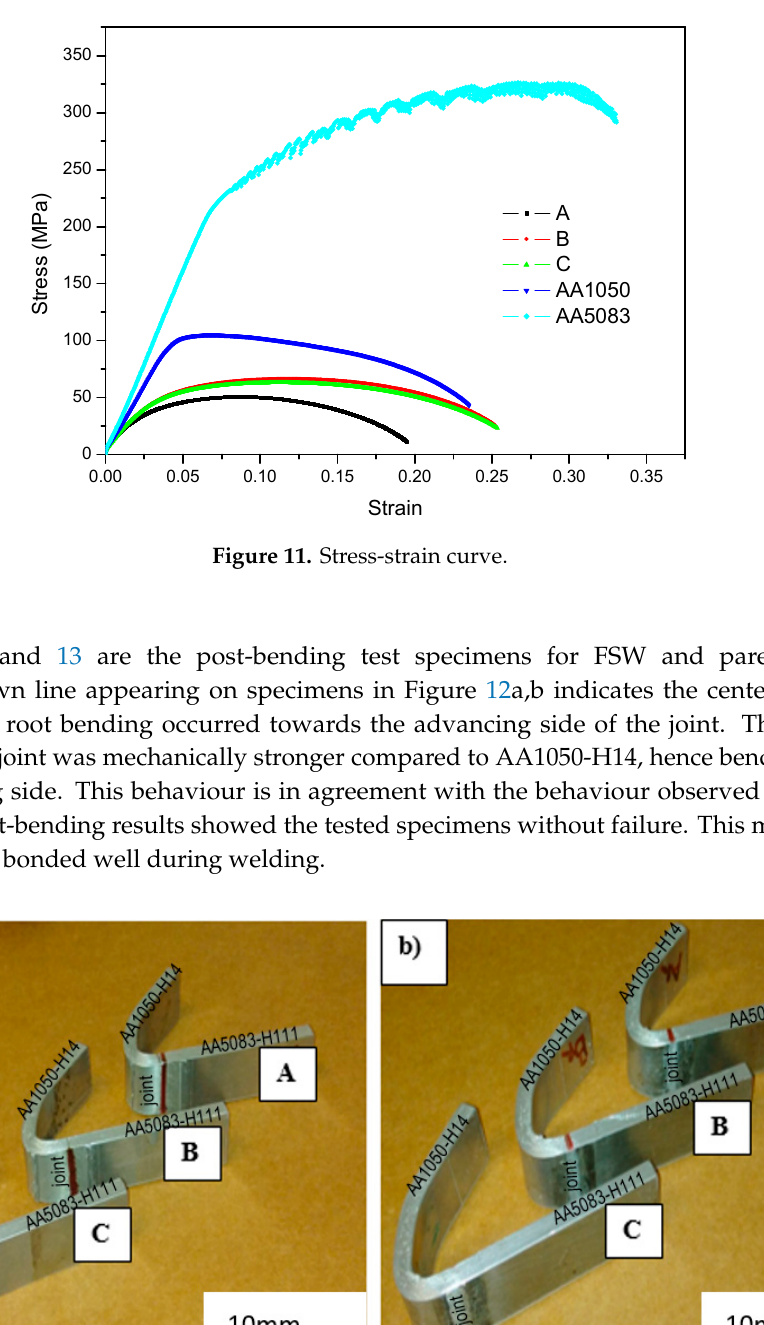
Figure 13. Tested bending specimen (parent materials).